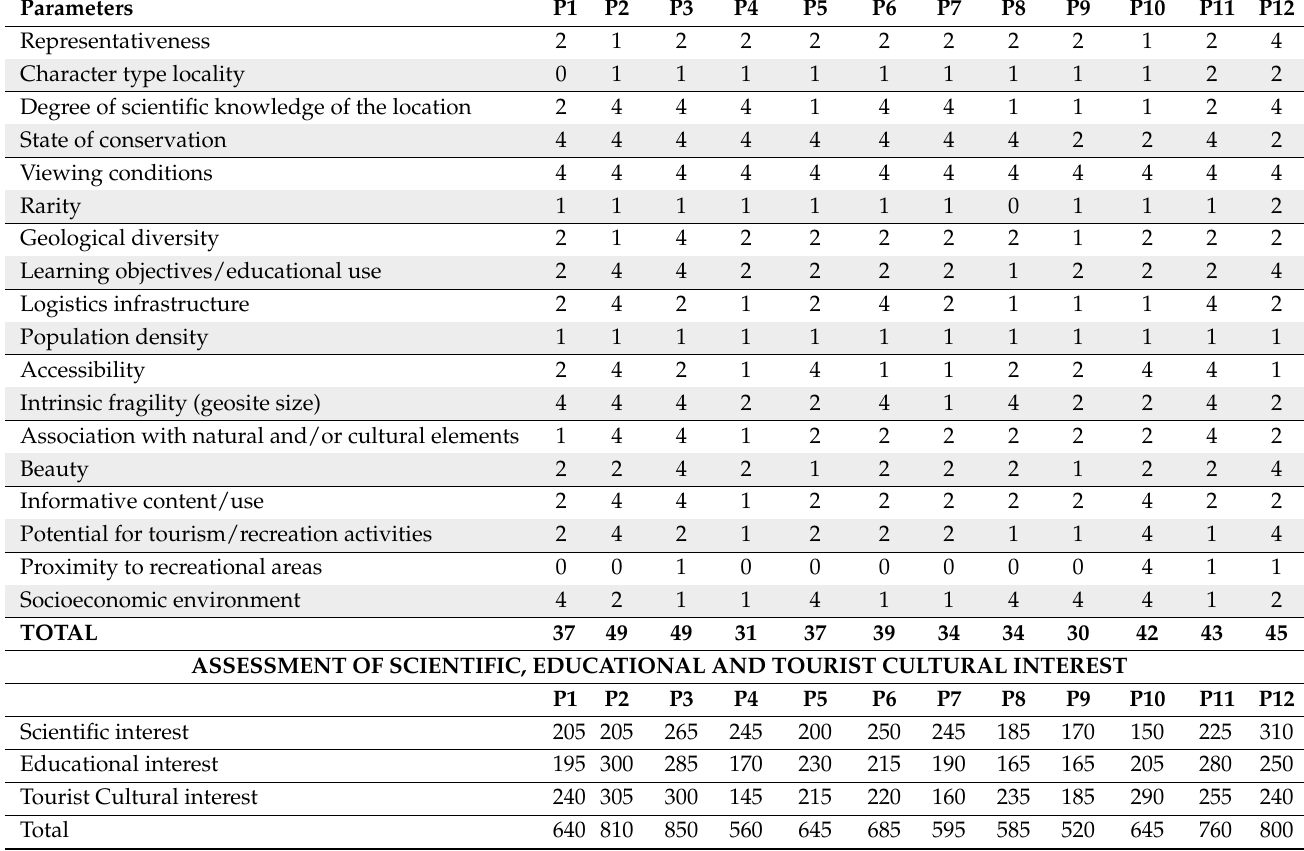
Table 2. Data that were obtained from the evaluations of each parameter by stops and results of the scientific, educational and cultural interest of each